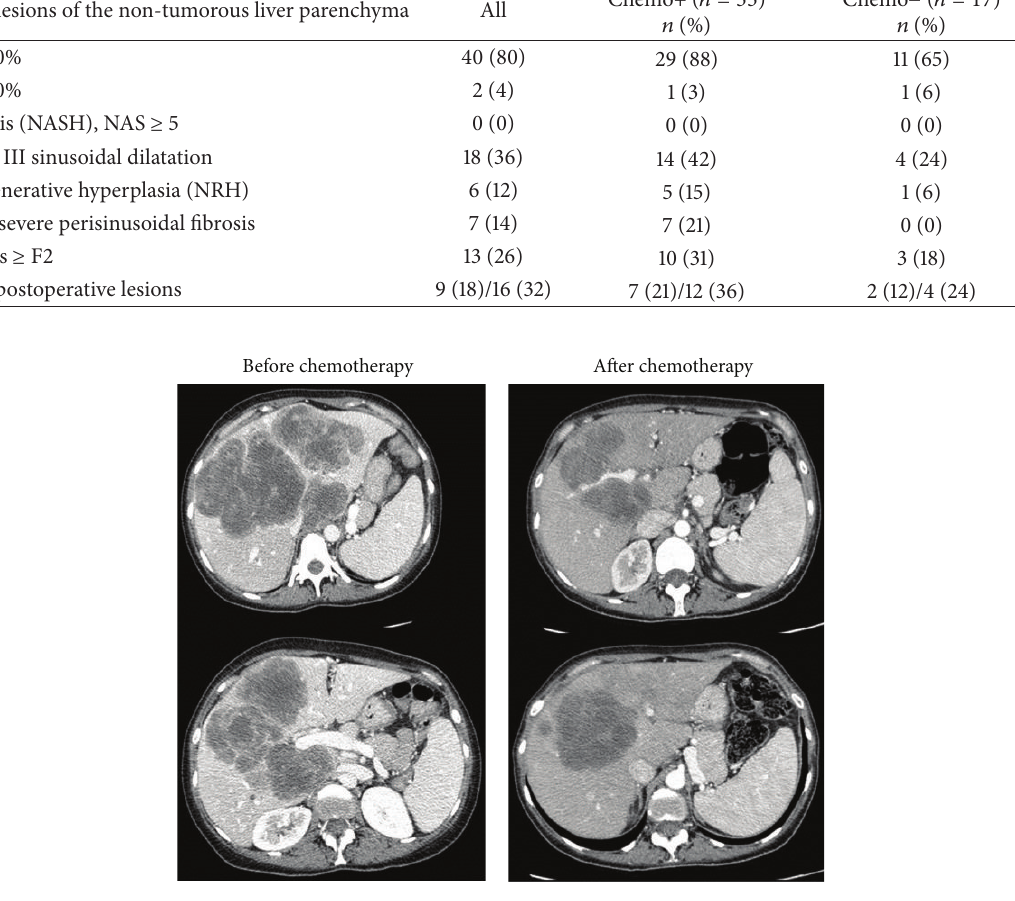
Figure 2: Example of a 41-year-old patient who developed HNR with portal hypertension after induction chemotherapy (FOLFOX, IV 12 cycles). An increase of the size of the spleen and an apparition of portal hypertension was observed after